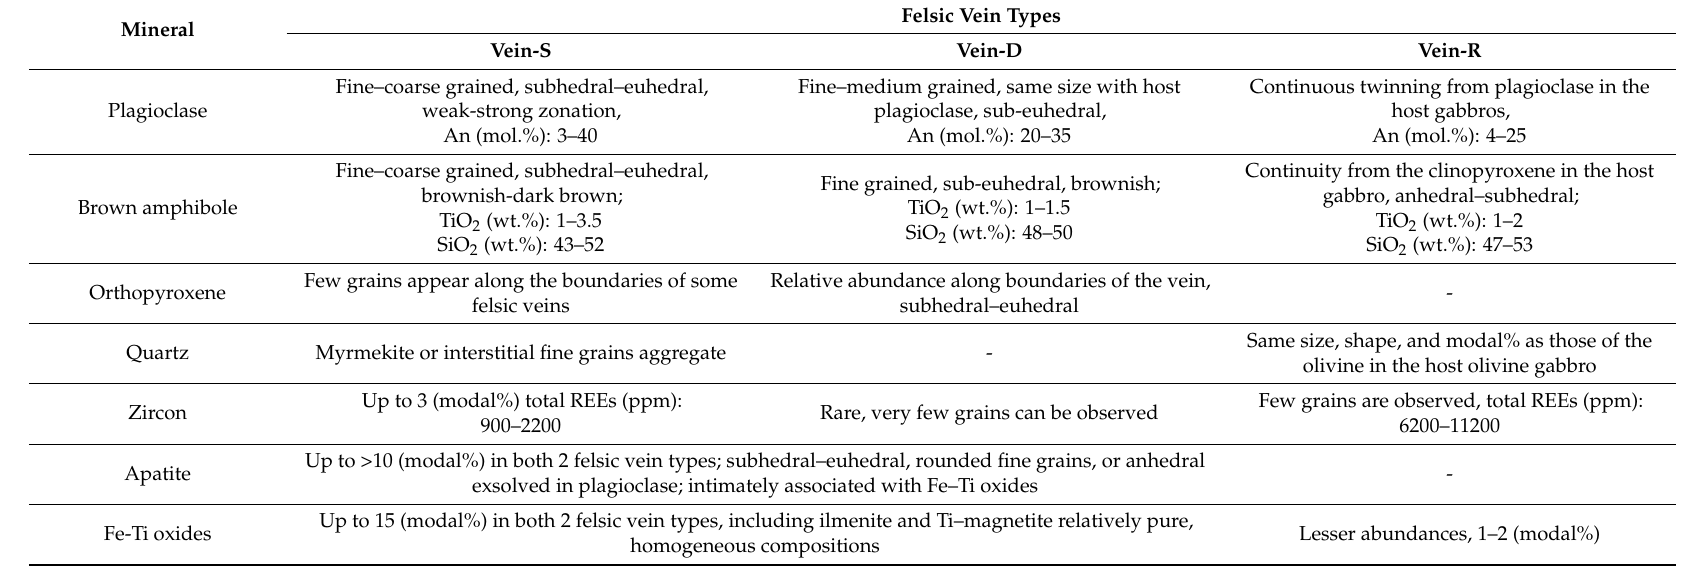
Table 3. Summary of the studied felsic vein types and mineral characteristics—Hole